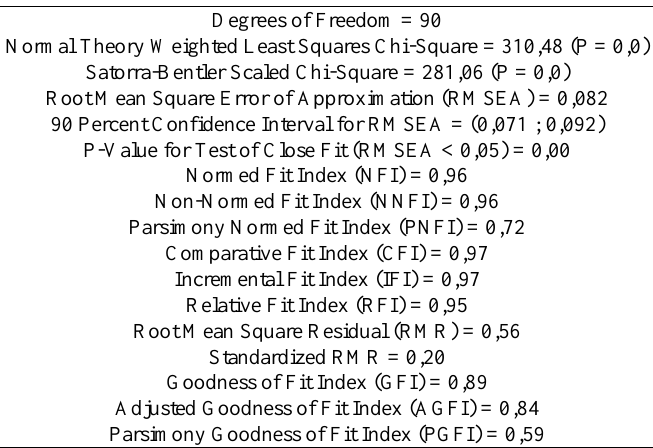
Table 4: Goodness of fit statistics for the